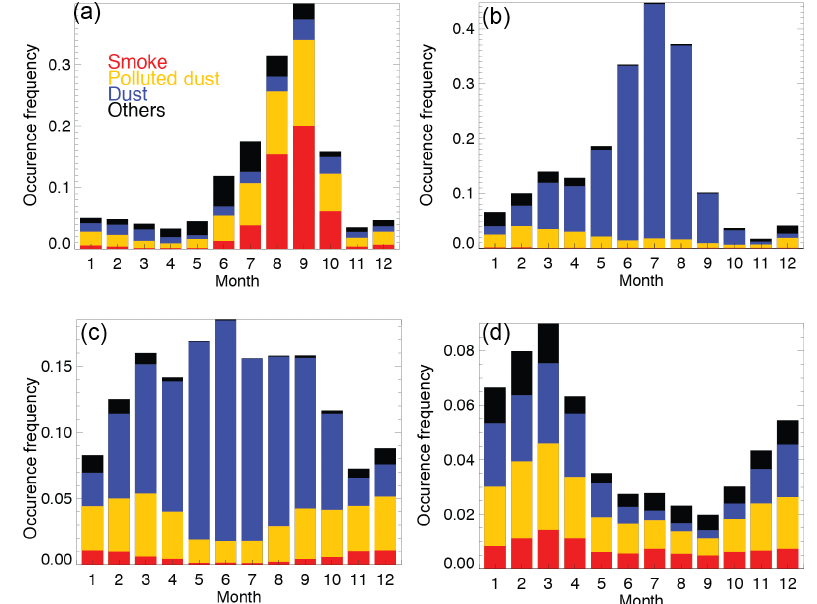
Figure 3. 8-year averaged monthly mean daytime occurrence frequency of aerosol types observed by CALIOP for the (a) southeast Atlantic region, (b) northern tropical Atlantic region, (c) Arabian Sea, and (d) northwestern Pacific.